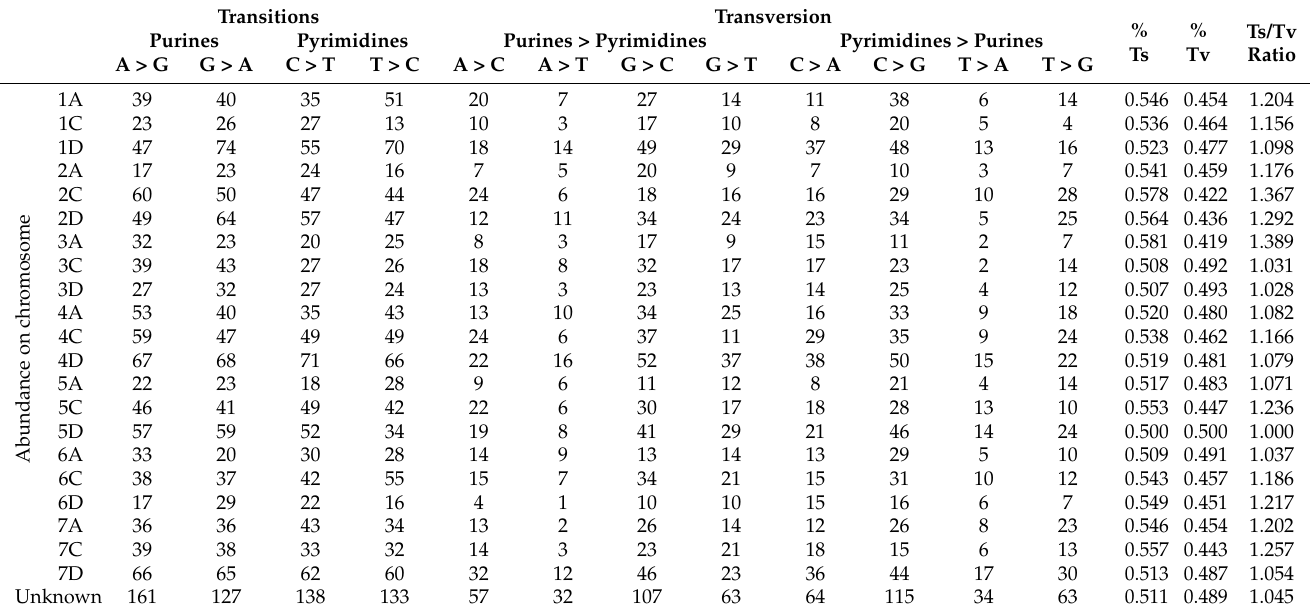
Table 1. Summary of point mutation abundance at the tested loci by chromosome based on DArTseq analysis of 487 A. sativa